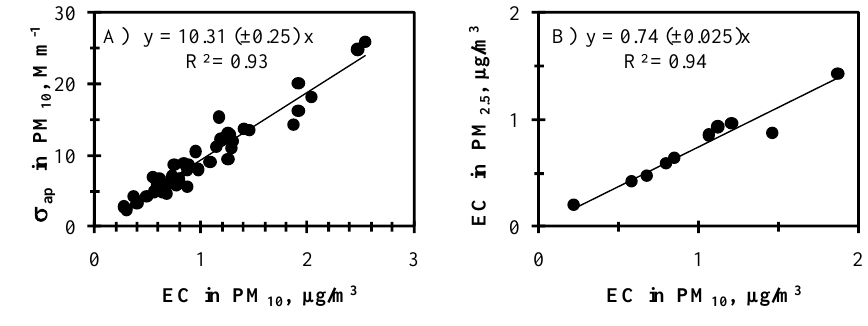
Fig. 3. (A) absorption coefficient σ ap versus EC concentrations in PM 10 particles, (B) BC in PM 10 versus BC PM 2 . 5